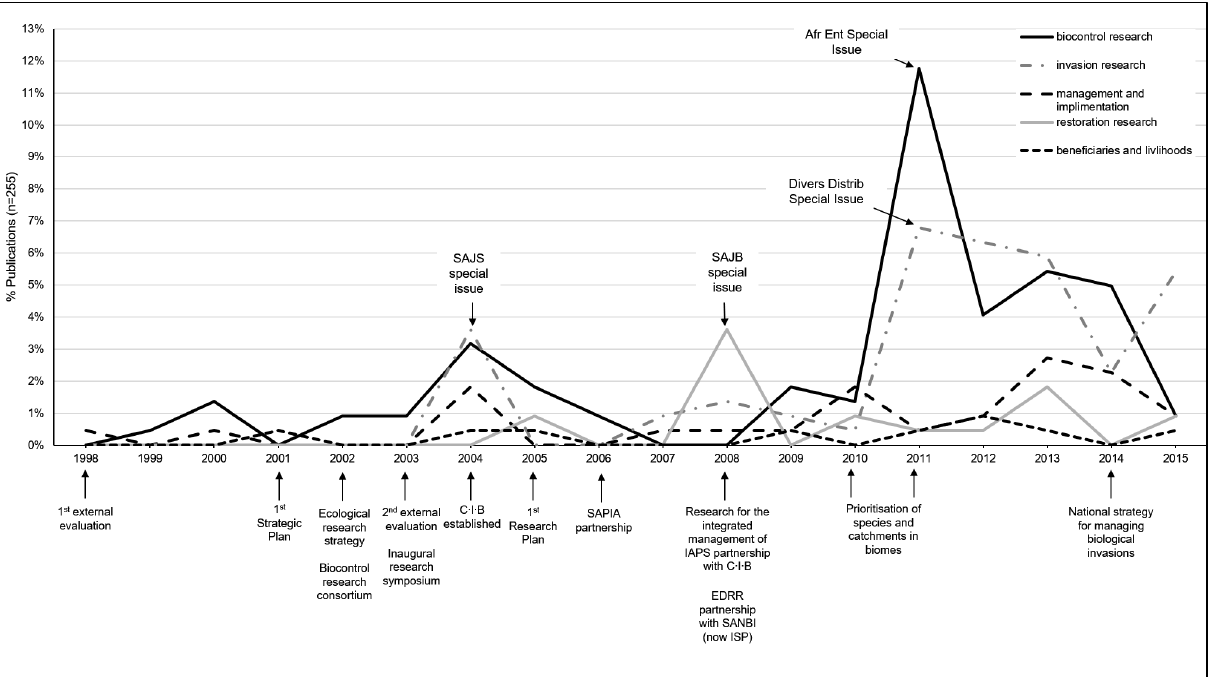
C•I•B, Centre for Invasion Biology; SAPIA, Southern African Plant Invaders Atlas; EDRR, Early Detection and Rapid Response; ISP, Invasive Species Programme; SANBI, South African National Biodiversity Institute; SAJS, South African Journal of Science ; SAJB, South African Journal of Botany Figure 2: Timeline of events in relation to research output associated with Working for Water research